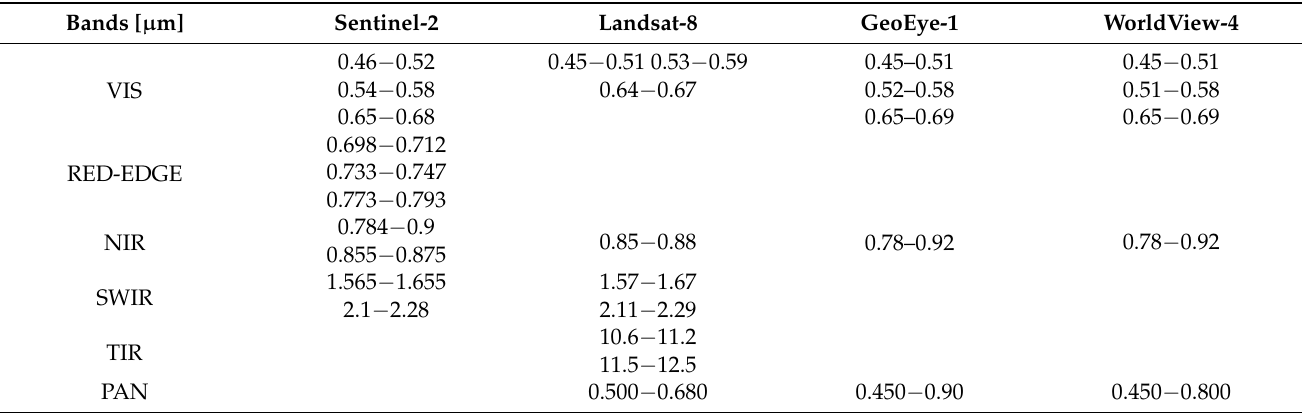
Table 1. Spectral coverage of the employed satellite